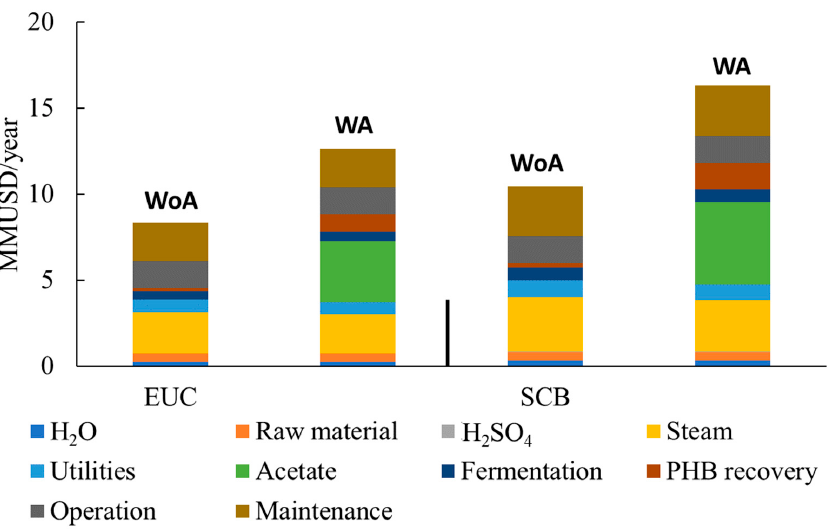
Figure 6. Production costs of selected scenarios. MMUSD: millions of USD. WA: with acetate. WoA: without acetate.